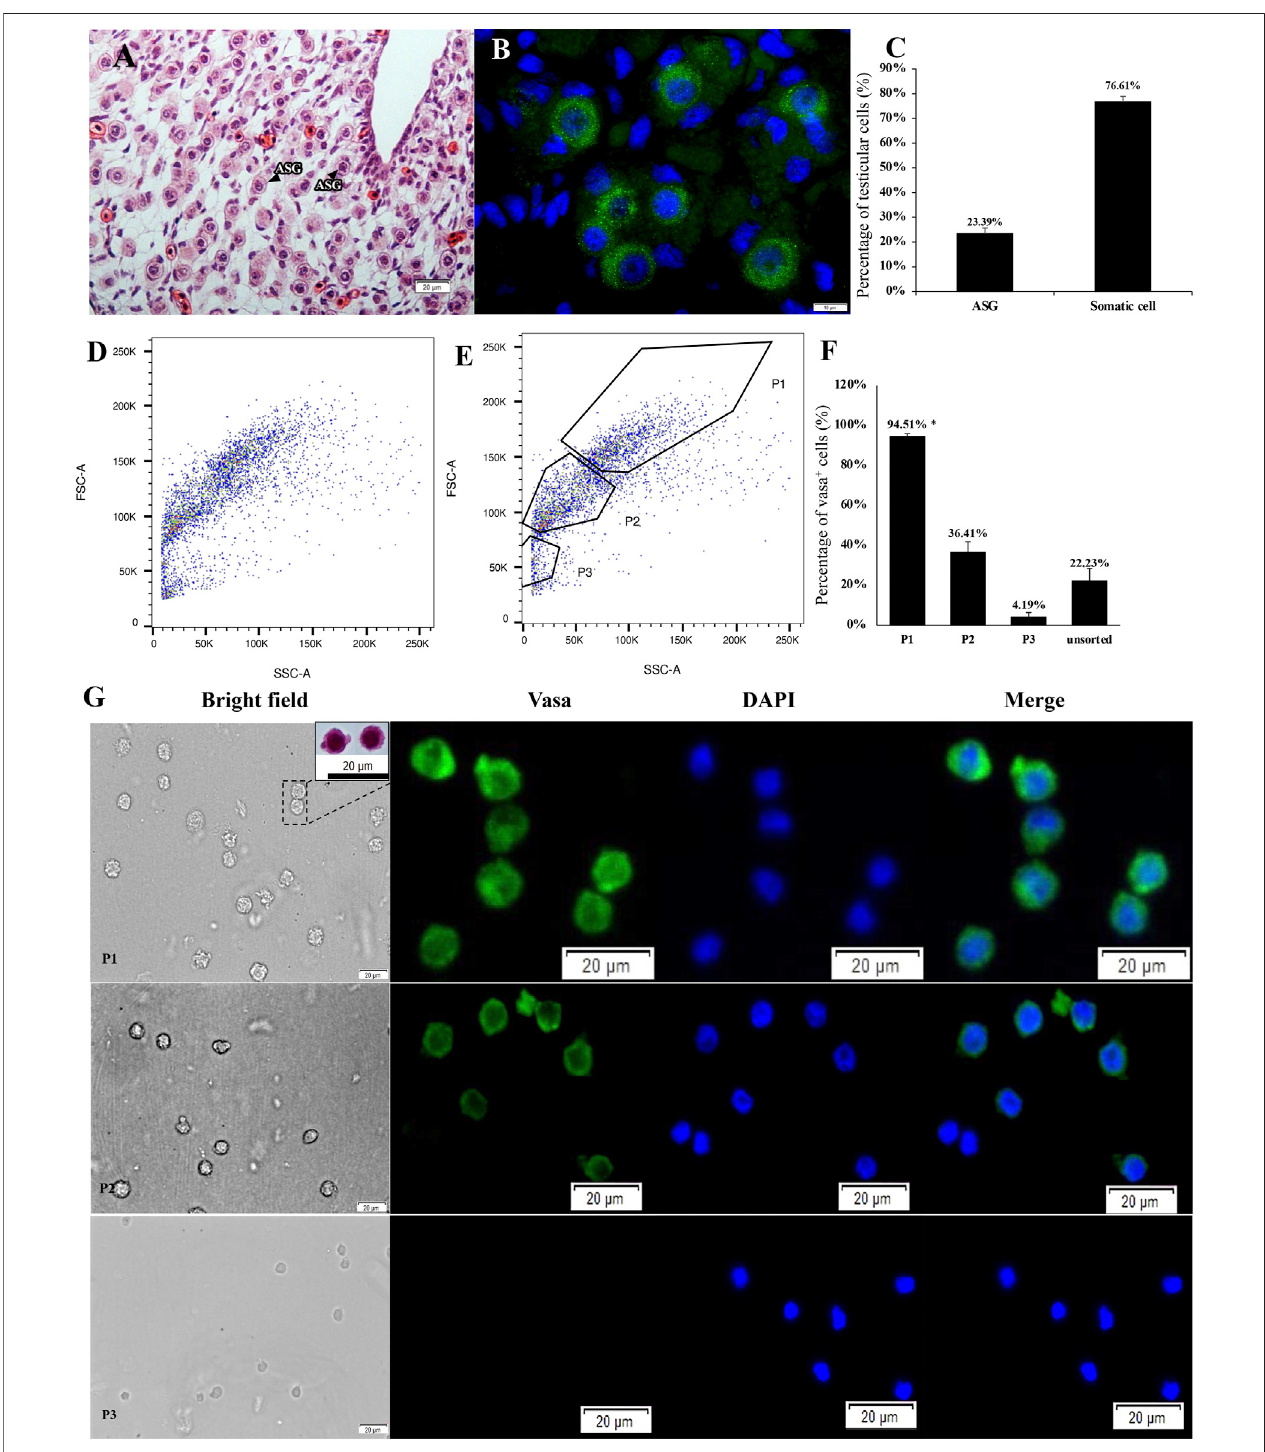
FIGURE 1 | Histological observation and light scattering property-dependent fractionation of 6 month-old sterlet testes. (A) Testes section stained with hematoxylinandeosin(HE). (B) Testessectionstainedwithanti-vasaantibody. (C) Theproportionofgermcellsandsomaticcellsintestes.ASG,typeAspermatogonia. (D,E) Bivariatehistogramsof fl owcytometrydatafromdissociatedtesticularcellspreparedfrom6 month-oldsterlets.GatesP1-P3weresetonthehistogramandused for cell sorting. (F) Vasa-positive rates of sorted cells in gates P1-P3 and unsorted live cells [mean ± standard deviation of mean (SD)]. Means with an asterisk indicate a signi fi cant difference (n (cid:1) 6, p < 0.05). (G) Microscopic observation of sorted cells using gates P1-P3 and HE stained cells from gate P1 (small rectangle). Immuno fl uorescent staining for detection/calculation of vasa positive cells in different gates. Blue signal, DAPI staining, Green signal, vasa antibody staining.